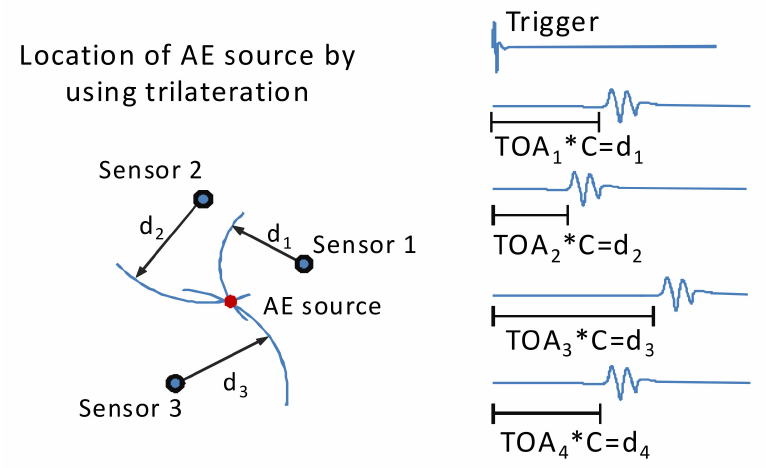
Figure 7. Position location of the AE source based on TOA measurements and trilateration.